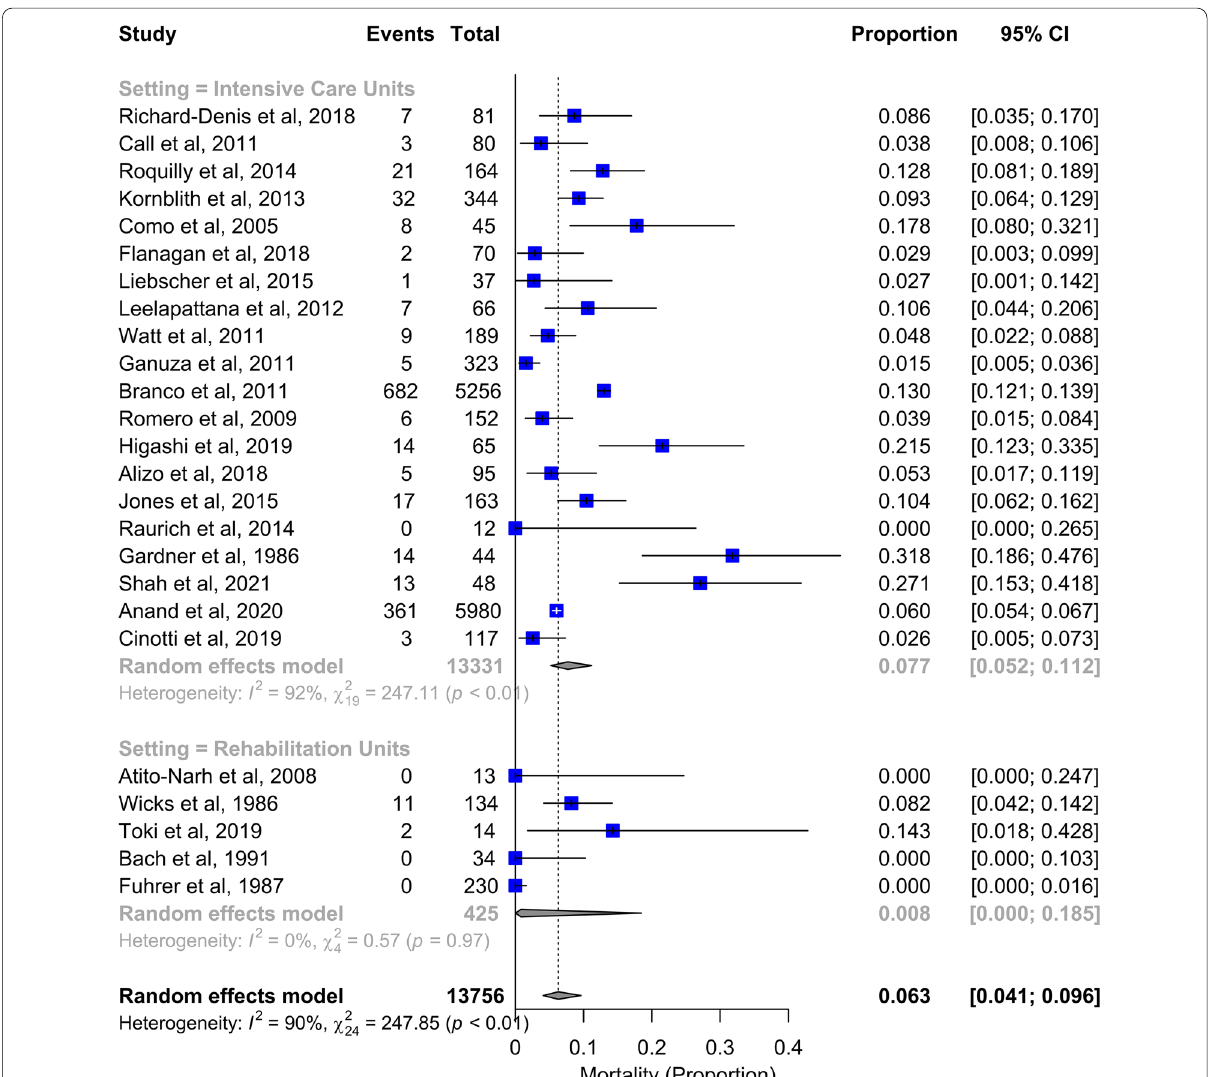
Fig. 4 Forest plot for mortality. Studies are presented according to setting classification (intensive care units vs rehabilitation units): both overall and subgroup estimates are reported. CI: confidence